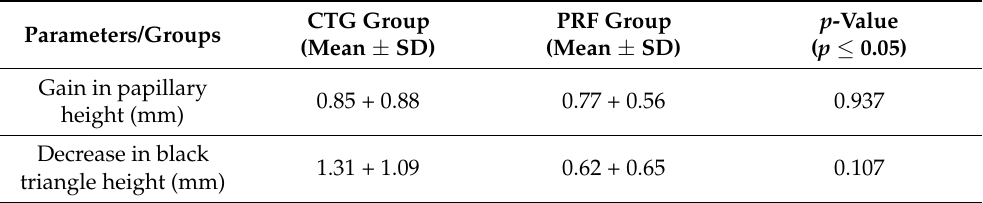
Table 4. Comparison of gain in papillary height and black triangle height reduction between the groups at 6